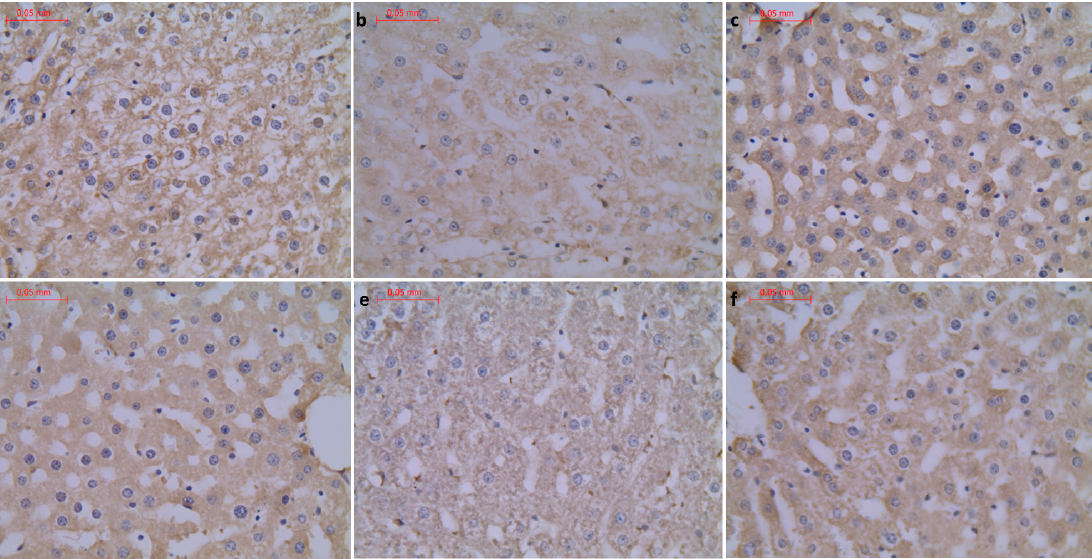
Figure 6. ( a ) Con-Sed, ( b ) Con-Run, ( c ) WP-Sed, ( d ) BP-Sed, ( e ) WP-Run and ( f ) BP-Run; immuno- stainings against α -SMA; OD analysis of α -SMA showed increased expression in WP-Run group compared to the Con-Run group.